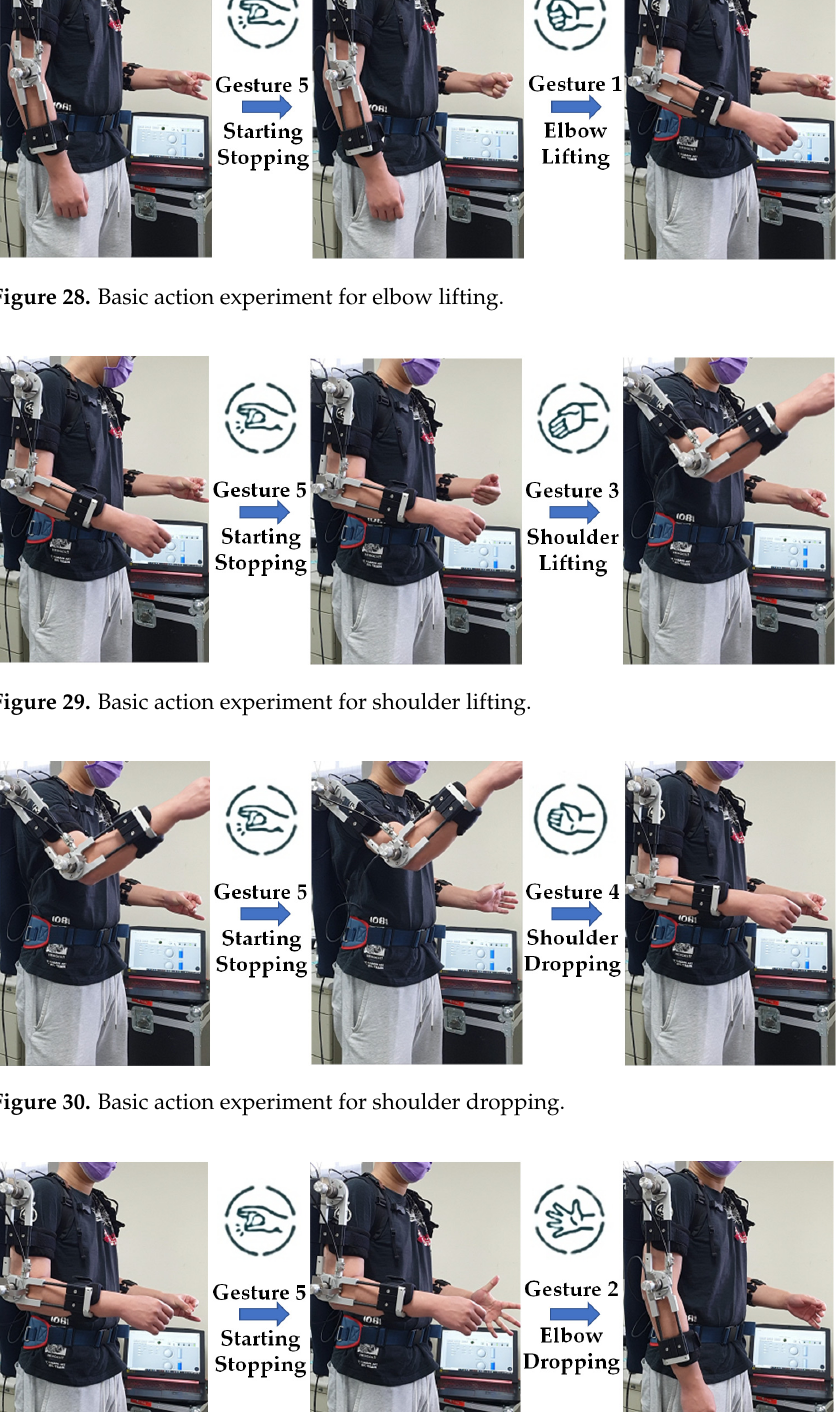
Figure 31. Basic action experiment for elbow dropping.